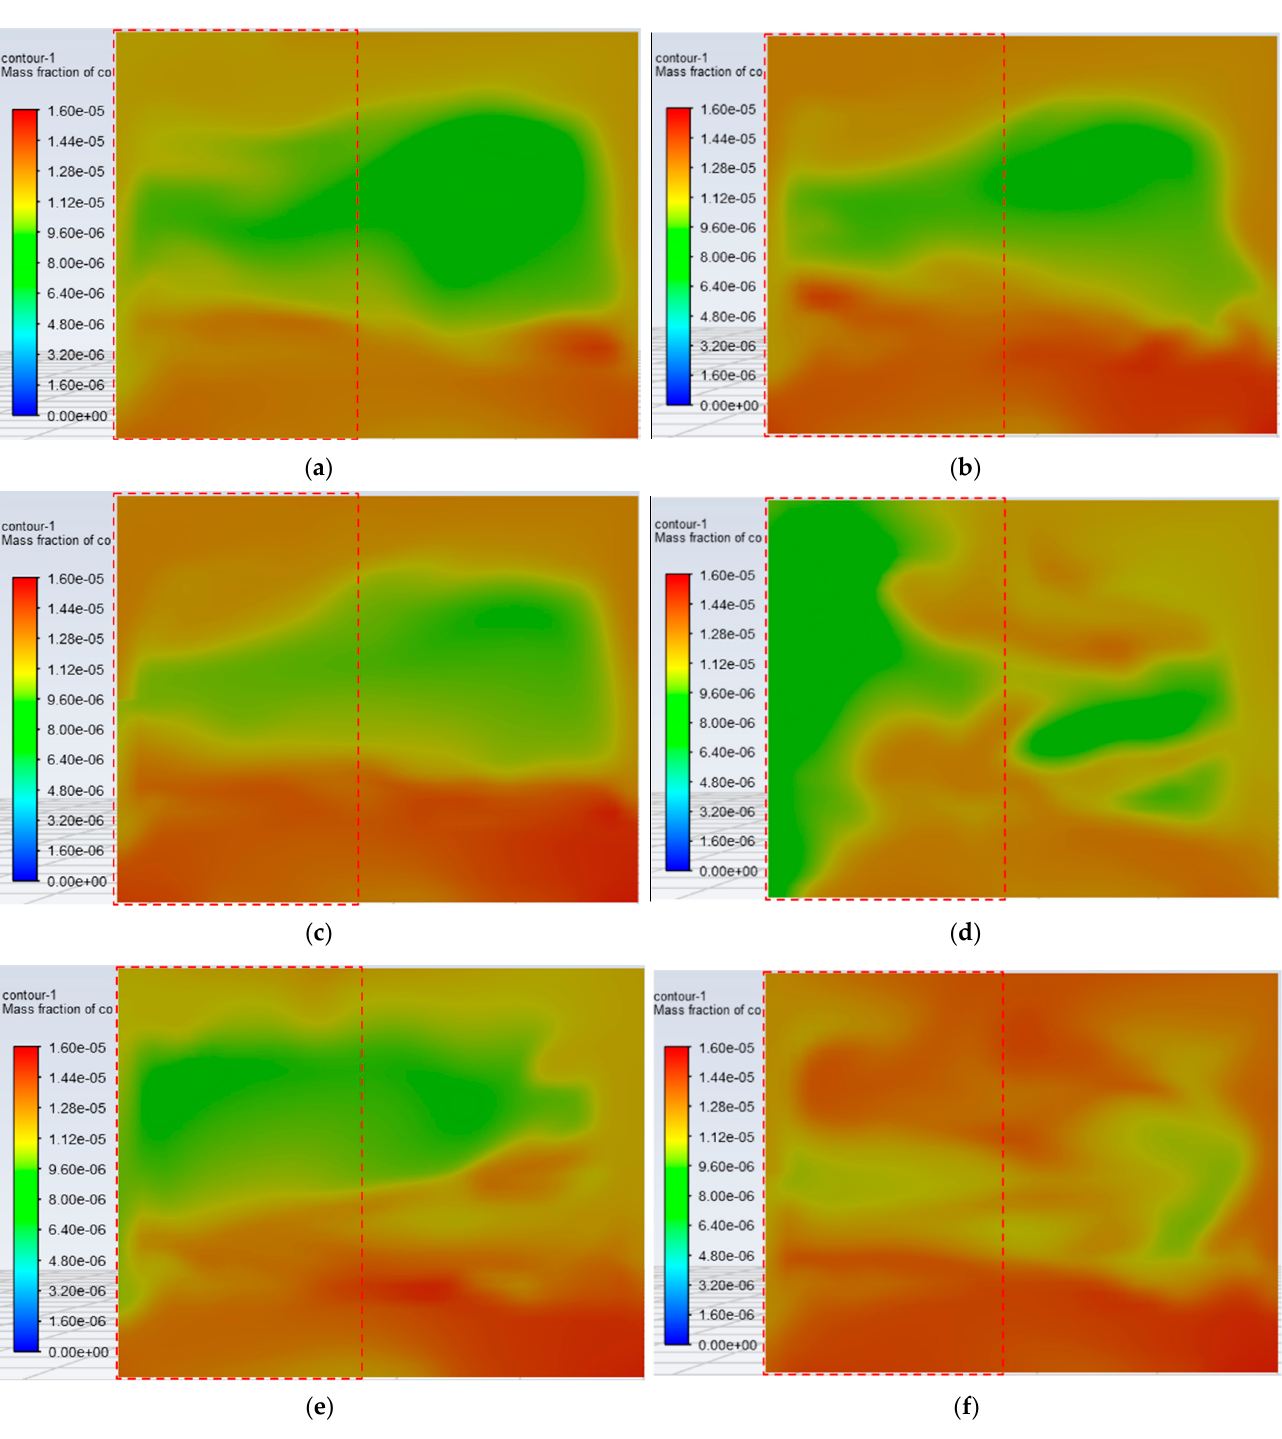
Figure 13. Contours of indoor 1.2 m high plane CO concentration distribution under six schemes: